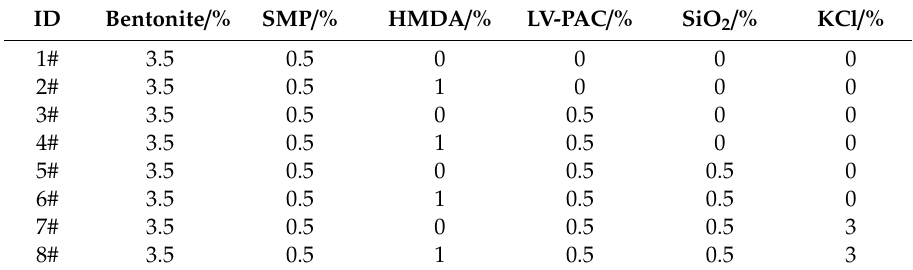
Table 1. The preparation of di ff erent mud cakes with di ff erent drilling